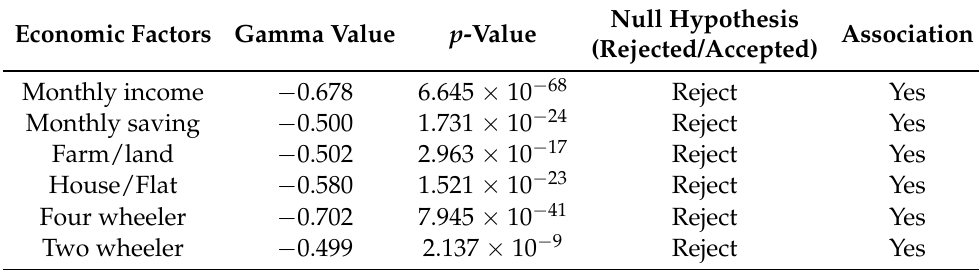
Table 4. Goodman and Kruskal’s gamma correlation between economic factors of buyer/non-buyer.